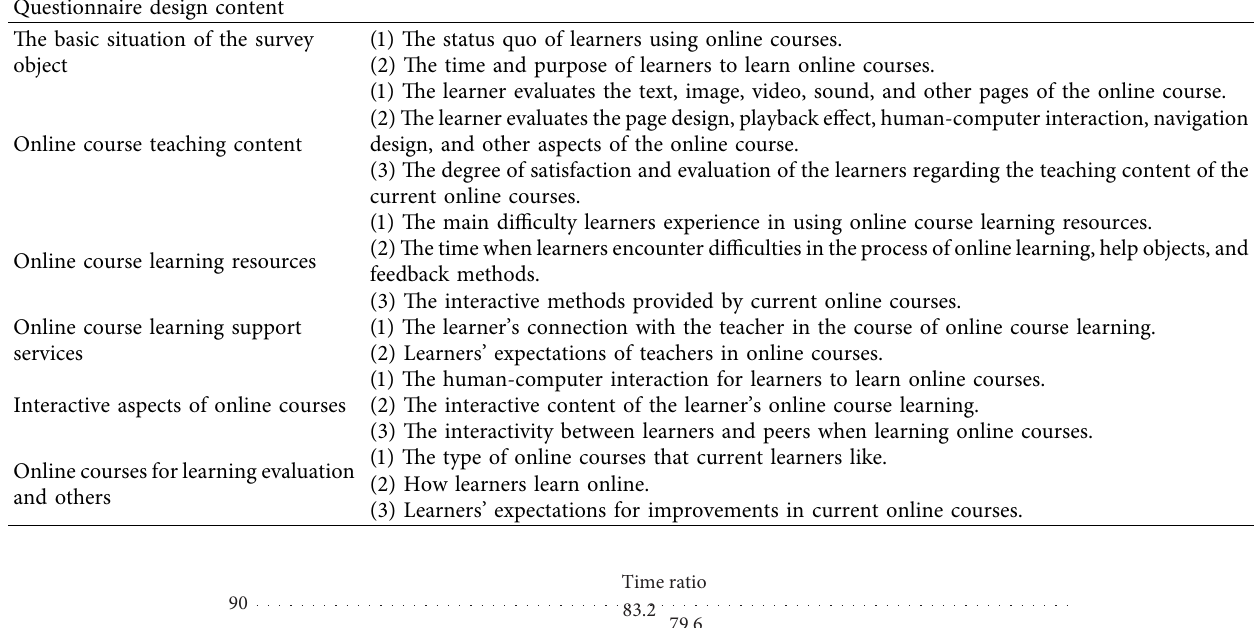
Table 1: Questionnaire design and analysis ideas.